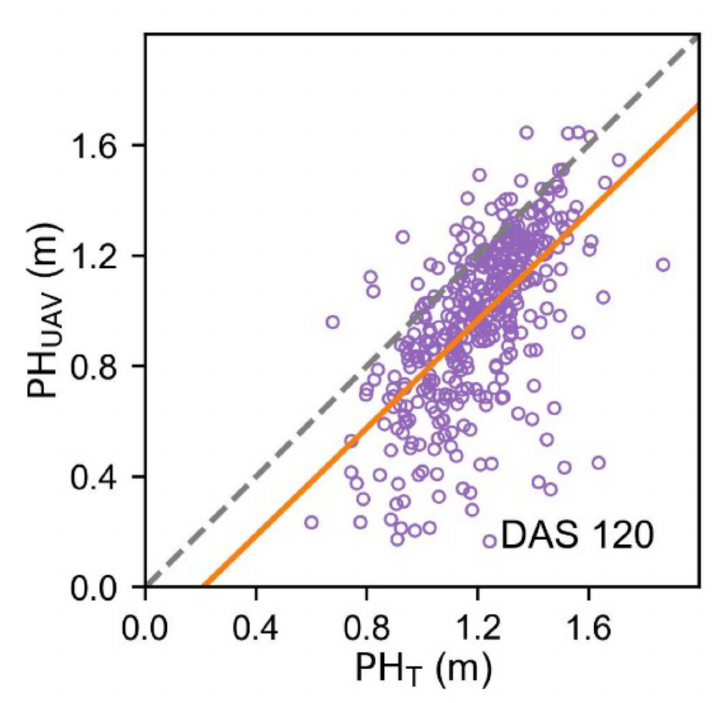
Figure 6. Comparison of UAV-based plant height estimation (PH UAV ) and manually measured tassel height (PH T ). The linear regression line is shown in orange and its equation is specified in Table 2; DAS: days after